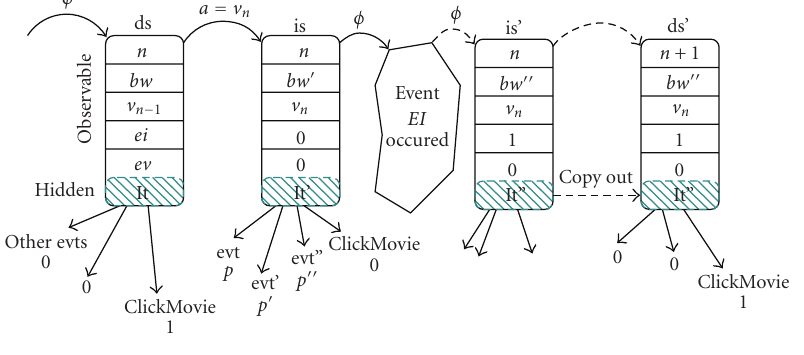
Figure 8: POMDP dynamics between hidden states.